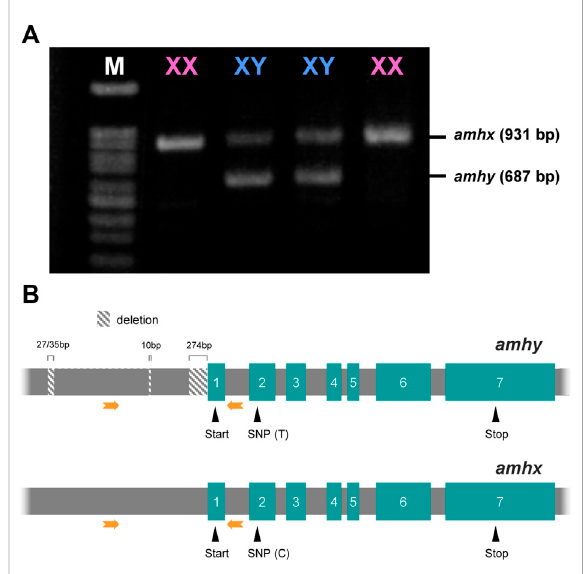
FIGURE 2 Ampli fi cation pattern of 5 ′ upstream region and the structure of amhy and amhx genes in P. olivaceus . (A) Agarose gel electrophoresis of amhx and amhy 5 ′ upstream region ampli fi ed by PCR in XX and XY individuals, phenotypic females and males, respectively; amhy band is shorter than amhx due to deletions inthe presumptive promoter. (B) Structures of amhy and amhx genesshowingthepositionofthree amhy -speci fi cdeletions inthe5 ′ upstreamregion,bothstartandstopcodons,and aSNP in the second exon; thymine (T) and cytosine (C) in exon 2 were highly linked to amhy and amhx , respectively. Green boxes represent the exons with the respective number and grey boxes in between represent the introns. Orange arrows indicate the position of primers used in